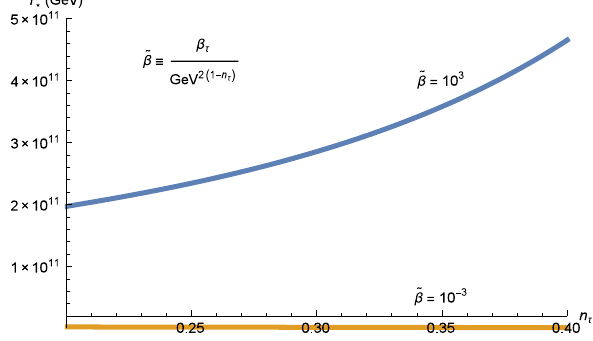
Fig. 2 T ∗ vs n . For fixed values of β , the transition temperature occurs at 10 11 − 10 9 GeV, i.e. T ∗ (cid:8) m χ